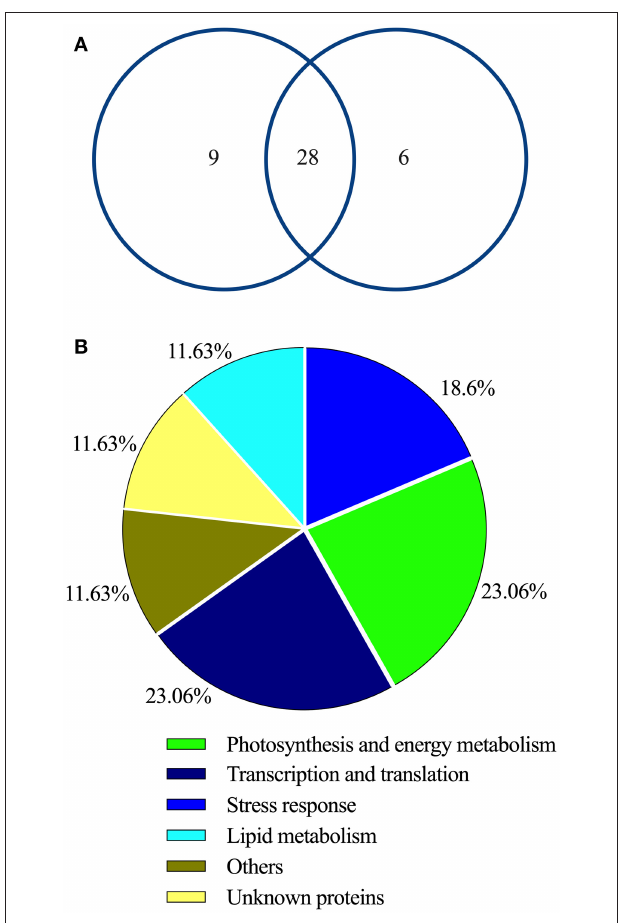
FIGURE 5 | (A) The Venn diagram and (B) functional classification of 43 identified and quantified proteins from three different ecotypes of reed.